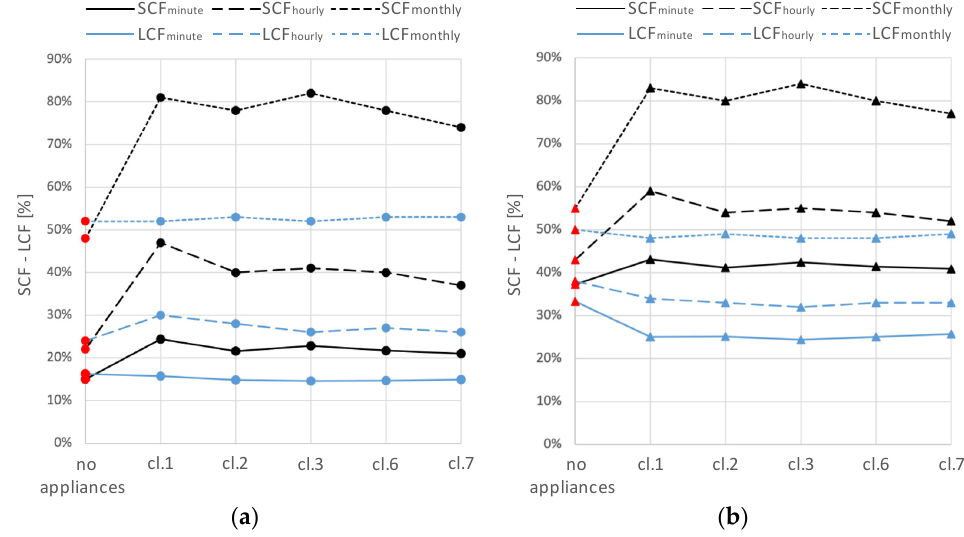
Figure 8. SCF and LCF factor, without (red) and with appliances (black) and bas ( a ) or enh ( b ) controls.